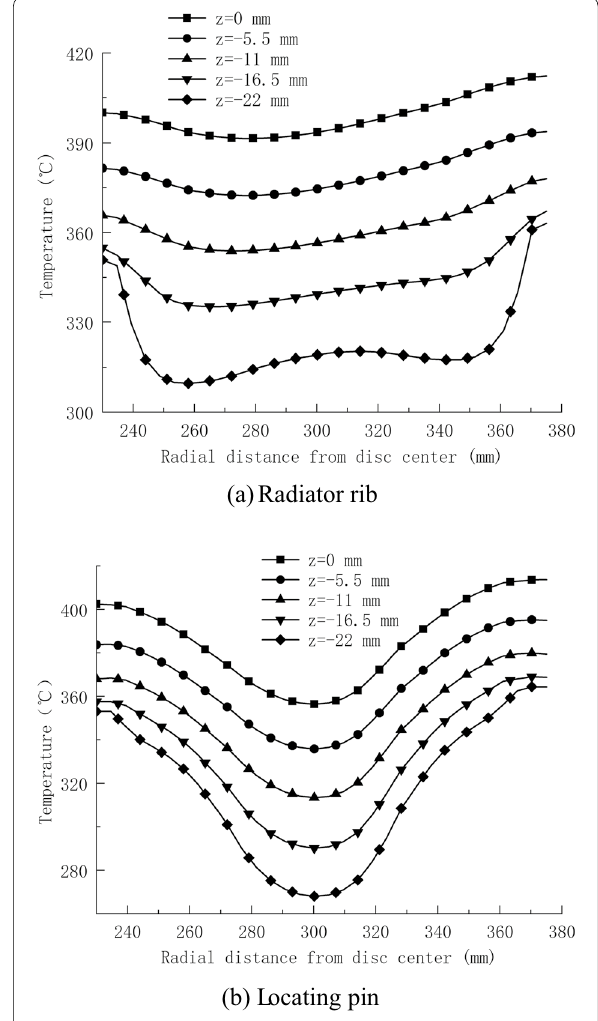
the radiator rib and locating pin of the friction ring surface at the highest temperature of the brake